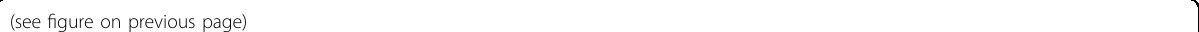
Fig. 1 1: Morphological changes occurring in hMSCs during various time points (day 3, day 5, day 10 and day 12) of neuronal induction. (i) BM-MSC, (ii) AD-MSC and (iii) DP-MSC. The morphology of hMSCs has changed from spindle shaped to perikaryl. Appearance of neuronal morphology starts appearing from 6 to 7th day of induction (scale bar 100 µm). 2: Morphological and Morphometric Characterization of differentiated hMSCs: A Scanning electron microscopic observations depicting minute morphological changes occurring in hMSCs after neuronal induction (i) morphology of hMSCs has changed from spindle shaped to perikaryl. Terminals of the cells show appearance of minute neurites ’ -like structures, which enhance cell-cell interactions. Here, # denotes neuritis, *denotes cell body and (cid:129) denotes axon hillock (Scale bar 20 μ m). (ii) magni fi ed images of differentiated cells, showing the appearance of axon-hillock, neuritogenesis and appearance of terminal neurites, facilitating cellular responses and interactions (Scale bar 2 μ m). B Morphometric analysis of the neuronal cells generated in vitro by using 22-HC (i) area of the cell body under various study groups. The graph depicts signi fi cant difference in this parameter between AD-MSC and DP-MSC; (ii) average length of neurites of differentiated cells after induction. The graph shows that the difference in the length of neurites is signi fi cantly higher in differentiated DP-MSCs, as compared to that in BM-MSCs and AD-MSCs; (iii) length of axons of cells after neuronal induction. The graph shows that the difference in the axonal length follows similar trend as average length of neurites; (iv) ratio of axon to cell body of cells under various study groups. The graph depicts that this morphological parameter of neuronal cells shows signi fi cant difference among all the three types of hMSCs under the study. Data points represent the means ± SD ( n = 3), * p < 0.001 vs. control untreated cells. For all the parameters under the study, fi ve different samples of each type of hMSC were taken ( n = 40 for each study group). Data was analysed by three independent